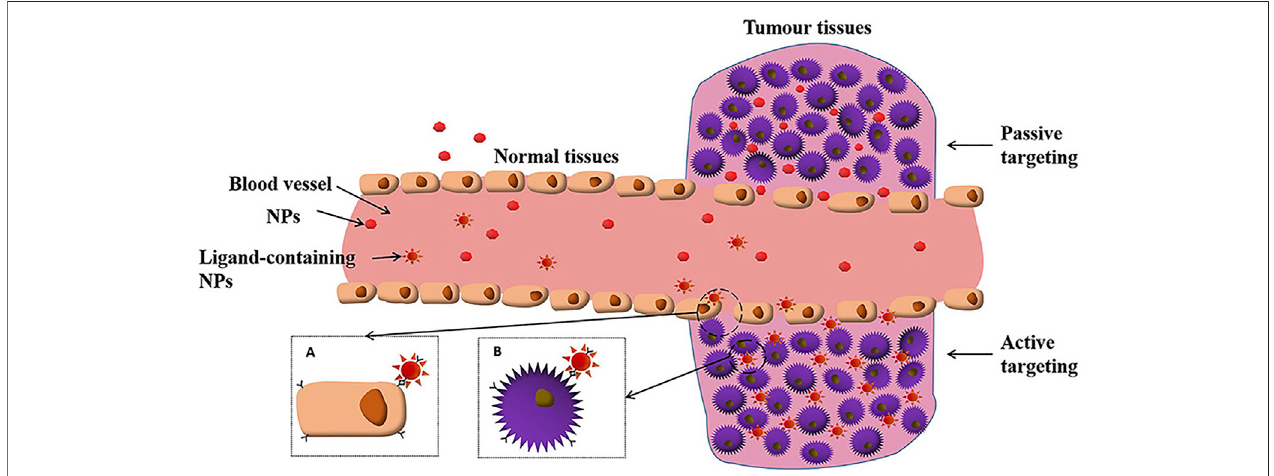
FIGURE 2 | Schematic illustration of the EPR effect, Active and Passive targeting. In tumour tissues, endothelial cells are irregular and have large gaps. Therefore, NPs tend to accumulate in tumor tissues much more than in normal tissues. In active targeting, targeting ligand-modi fi ed NPs can bind to speci fi c receptors on tumor cells or tumor endothelial